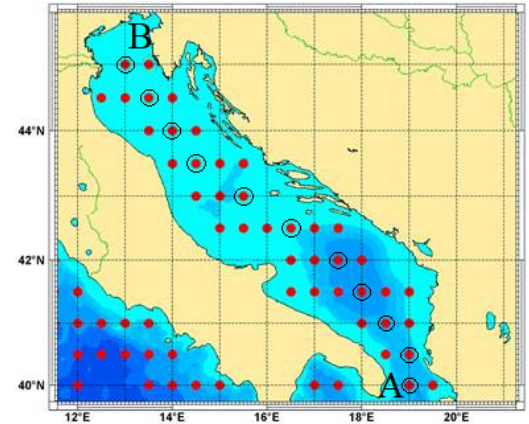
Figure 3. Locations in the Adriatic Sea according to WWA.